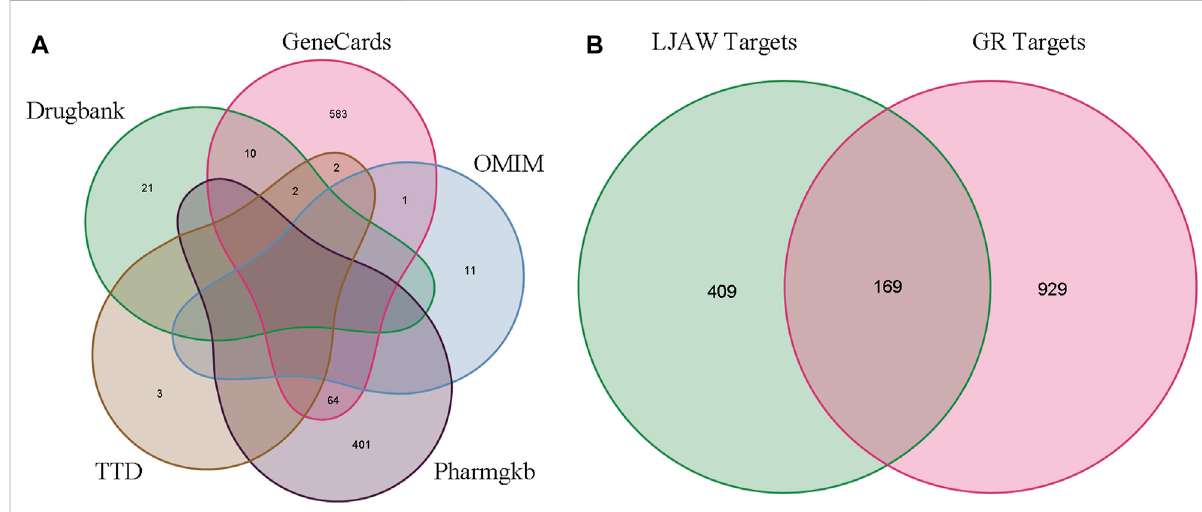
FIGURE 4 (A) Gastrointestinalreactions related targets in fi vedatabases. (B) Venndiagram ofrelated targets ofLJAW andgastrointestinal reactions caused by chemotherapy for colorectal cancer.